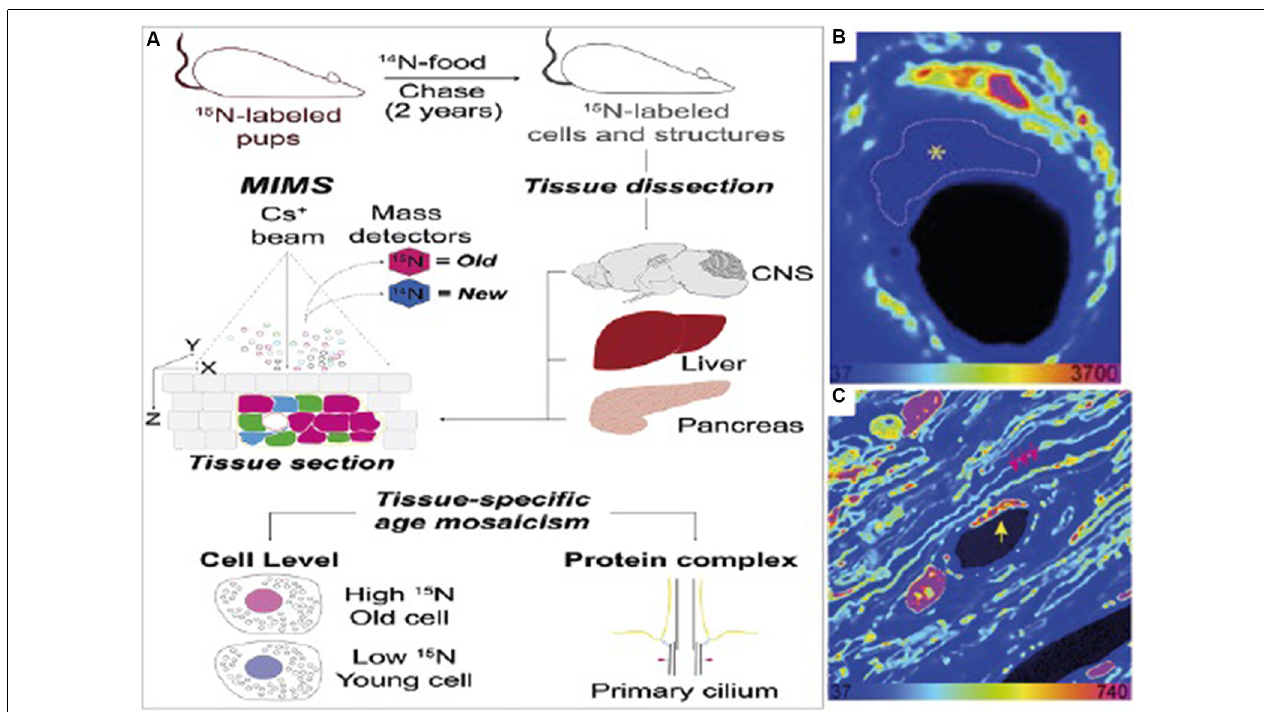
FIGURE 3 | (A) Sample measurement scheme for an isotope labeling NanoSIMS experiment. In this case, the isotope label used is 15 N, which is used to mark “older” cells. (B) NanoSIMS image from the optic nerve head (ONH) of the labeled mouse. Here, bright colors refer to older, labeled cells. The dashed line refers to an endothelial cell present in the electron microscopy image which does not have any discernible features in the NanoSIMS image. (C) NanoSIMS image of two capillaries in the ONH of a 6-month chase mouse. An endothelial cell nucleus (yellow arrow) and myelin sheaths (pink arrows) are indicated. A pericyte nucleus is visible to the left of the capillary lumen. Labeled cells are visible in comparison to unlabelled cells, illustrating the usefulness of isotope labeling methods applied to SIMS. Reprinted from Arrojo e Drigo et al. (2019) with permission from